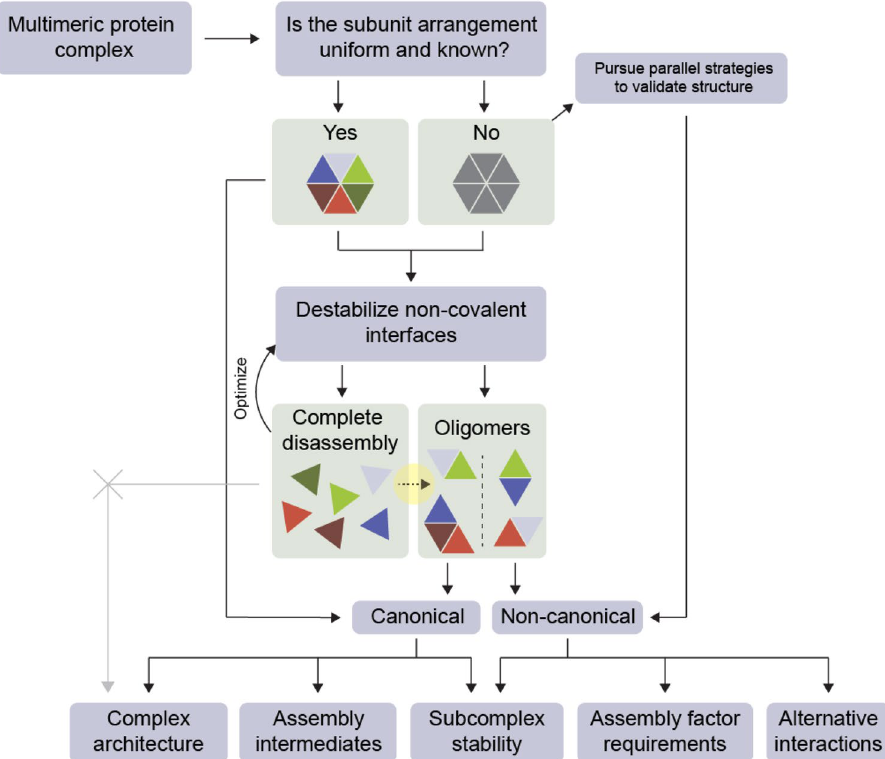
Figure 5. Updated conceptual workflow for solution dissociation coupled to native mass spectrometry. The highlighted arrow from Complete disassembly to Oligomers represents the novel pathway observed in this study, which can occur if, for example, subunits possess moonlighting functions with alternative partners or are paralogous and retain non-canonical interface compatibility. Assignment of contacts as canonical or non- canonical ensures that native MS is appropriately applied in integrative structural biology